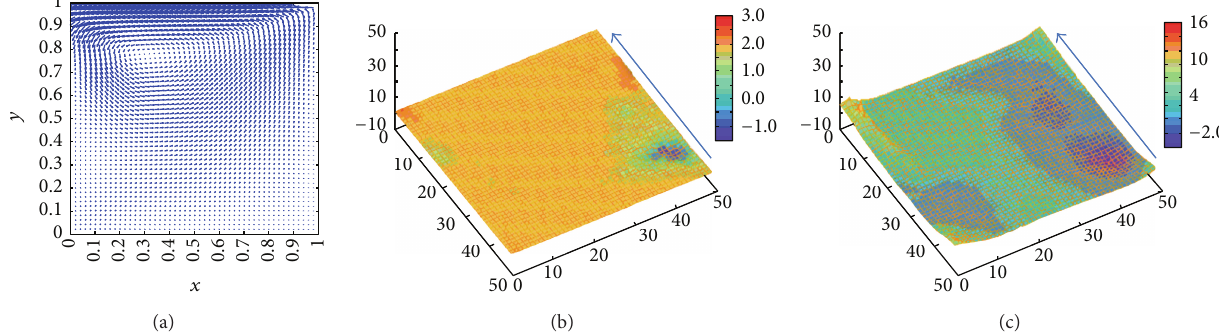
Figure 8: The sand ripples formation under the cavity flow model. (a) Air velocity distribution; (b) and (c) are sand bed morphology at 20th and 130th step.